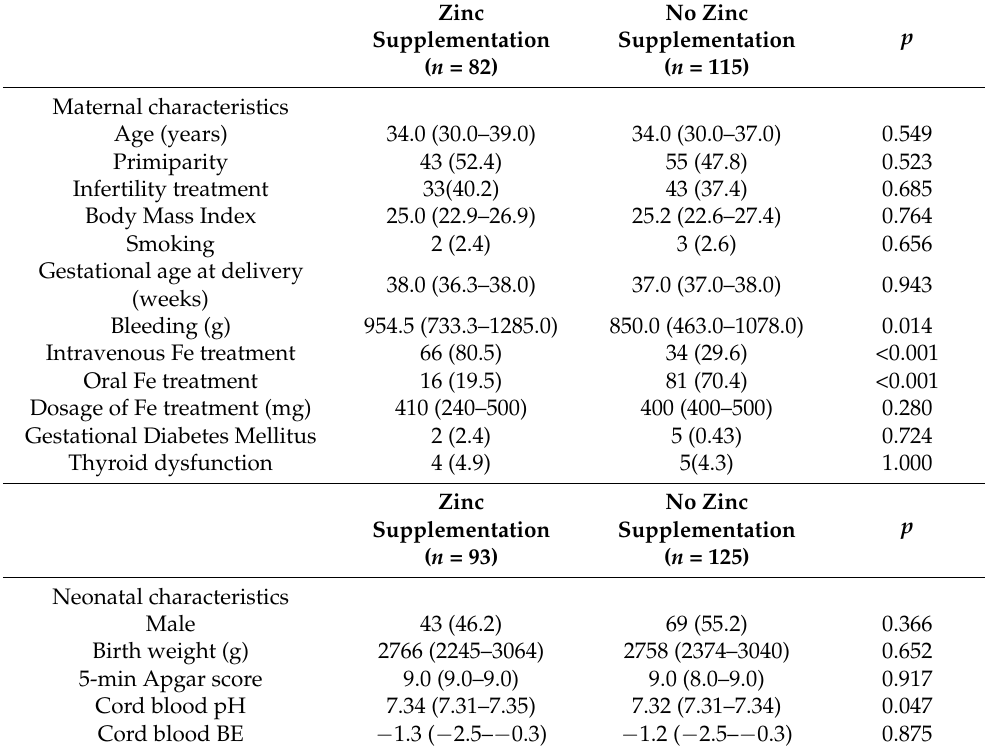
Table 1. The baseline characteristics of the cases in Analysis